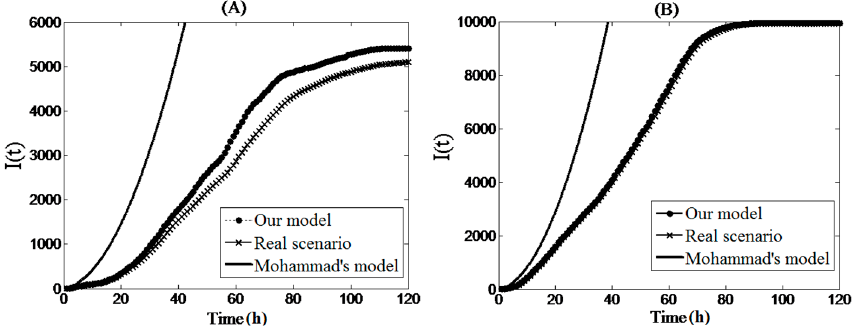
Figure 7. Our mathematical model vs. Mohammad’s individual boundaryless model (the network sizes of ( A ), ( B ) are 6000 and 10,000); I(t) means the number of infectedsensor nodes.